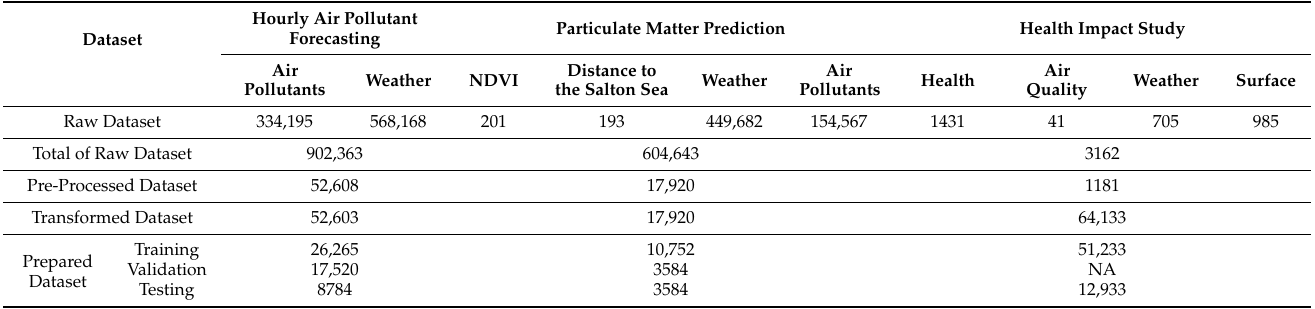
Table 4. Data statistics (created by